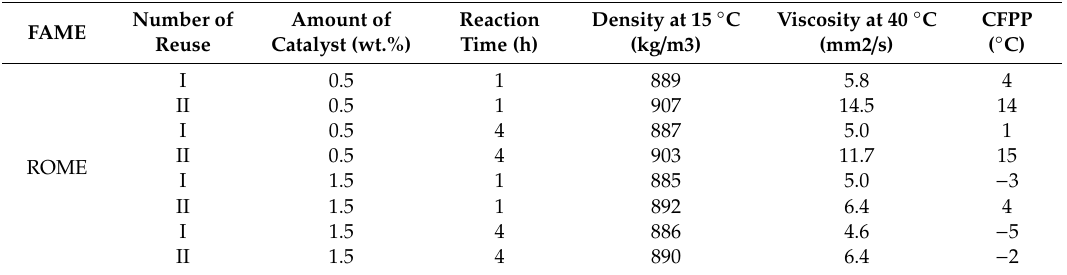
Table 2. The e ff ect of KOH / AC as catalyst on properties of ROME, SOME, COME, and OOME. [Molar ratio methanol-to-oil,